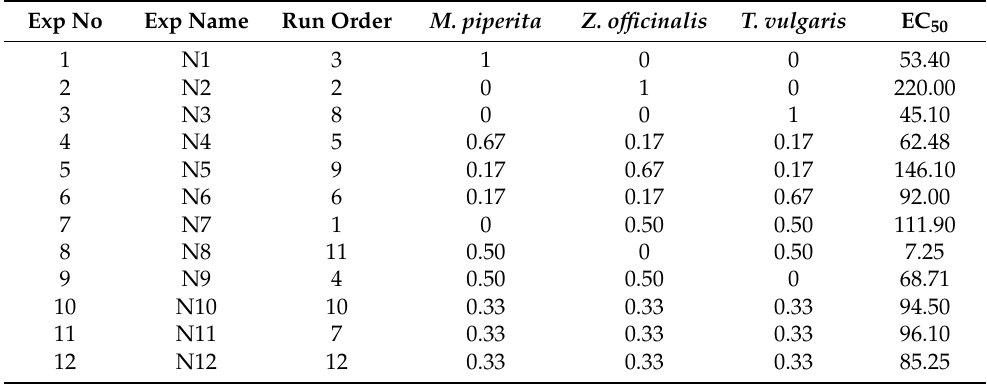
Table 4. The worksheet used to fit the model.